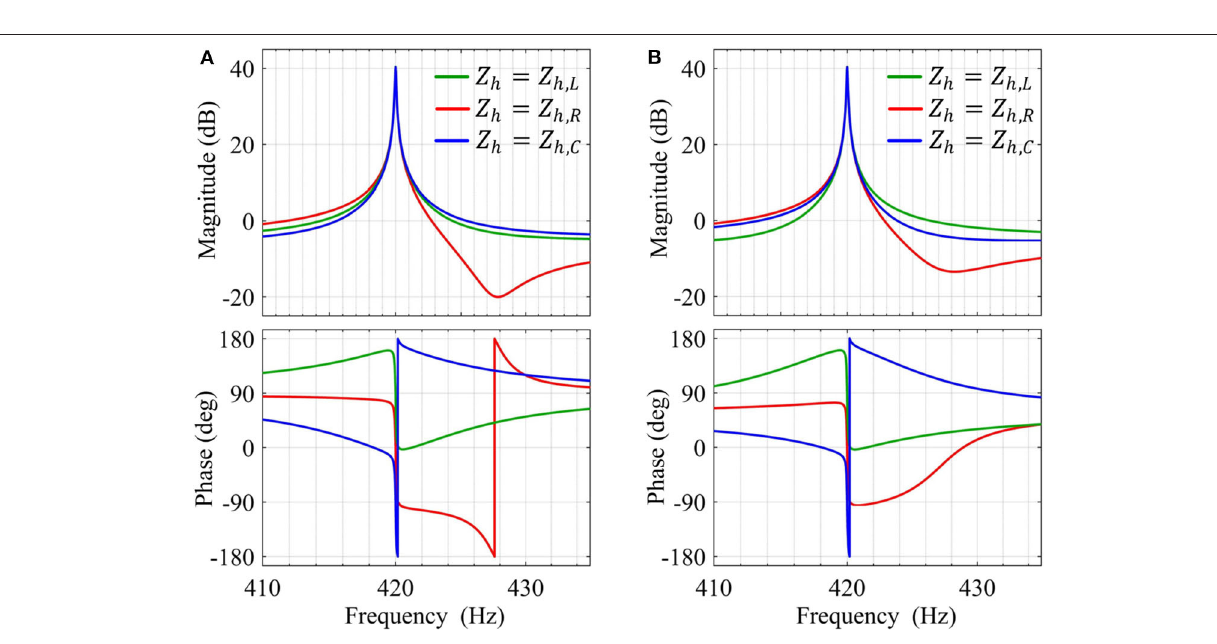
FIGURE 12 | Converter output impedance (zoomed in around harmonic order h impedance Z h ( s ) using grid-side current feedback, when (A) R vir